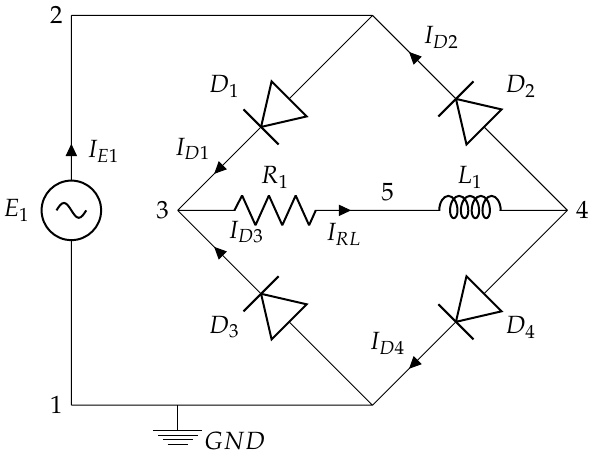
Figure 3. Model of a full wave rectifier.